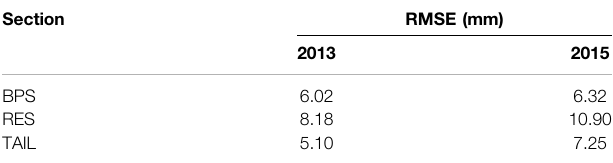
TABLE 1 | Root mean square errors (mm) of the relationships between growing degree-days (GDD) and size at capture ( L cpt ) for the different sections and years for chub collected in the reach of Caderousse (Rhône River, France).